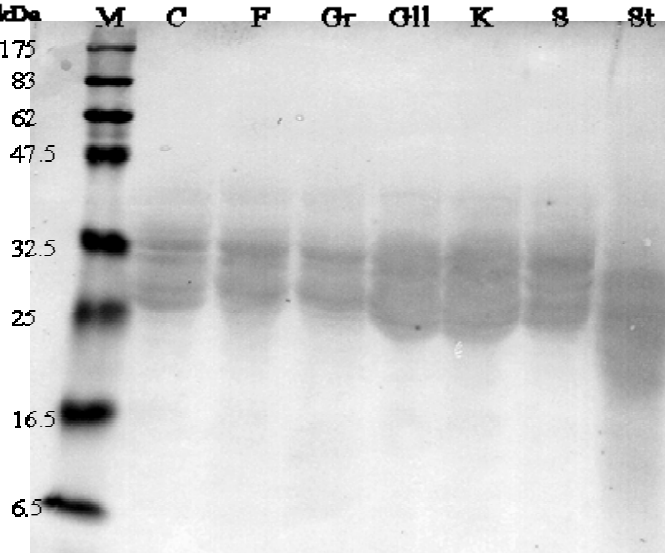
Figure 4. Immunoblotting of α -gliadin extracts with PN3 mAb. M: Prestained Protein Marker (New England Biolabs); C: Senatore Cappelli; F: Flaminio; Gr: Grazia;